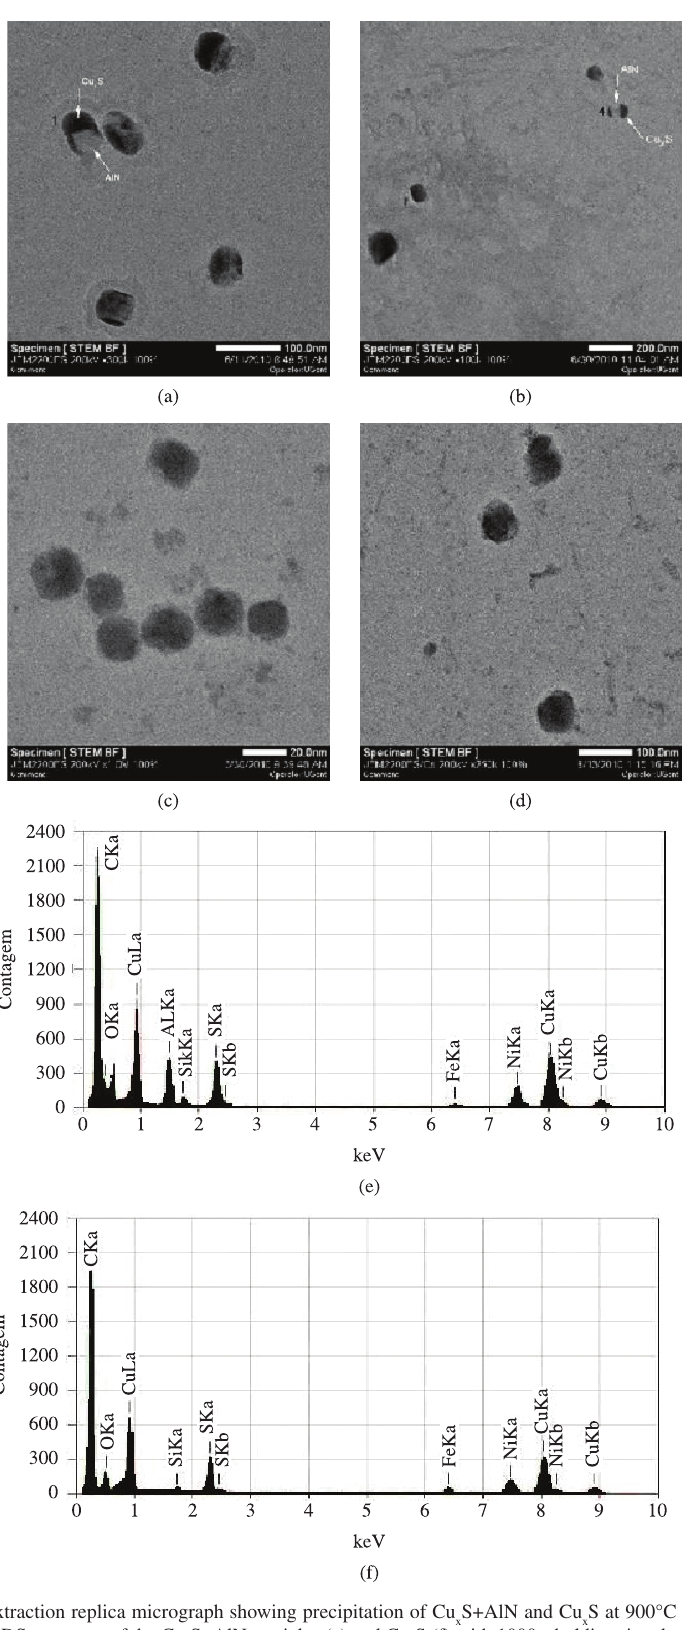
S+AlN particles (e) and Cu x